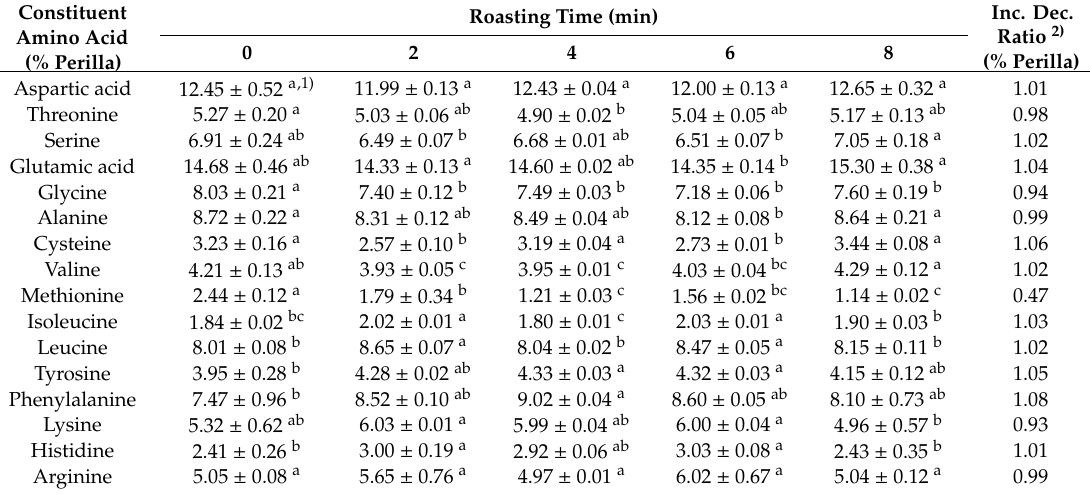
Table 3. Constituent amino acids in P. frutescens Britton var. acuta Kudo during the roasting. Constituent Amino Acid